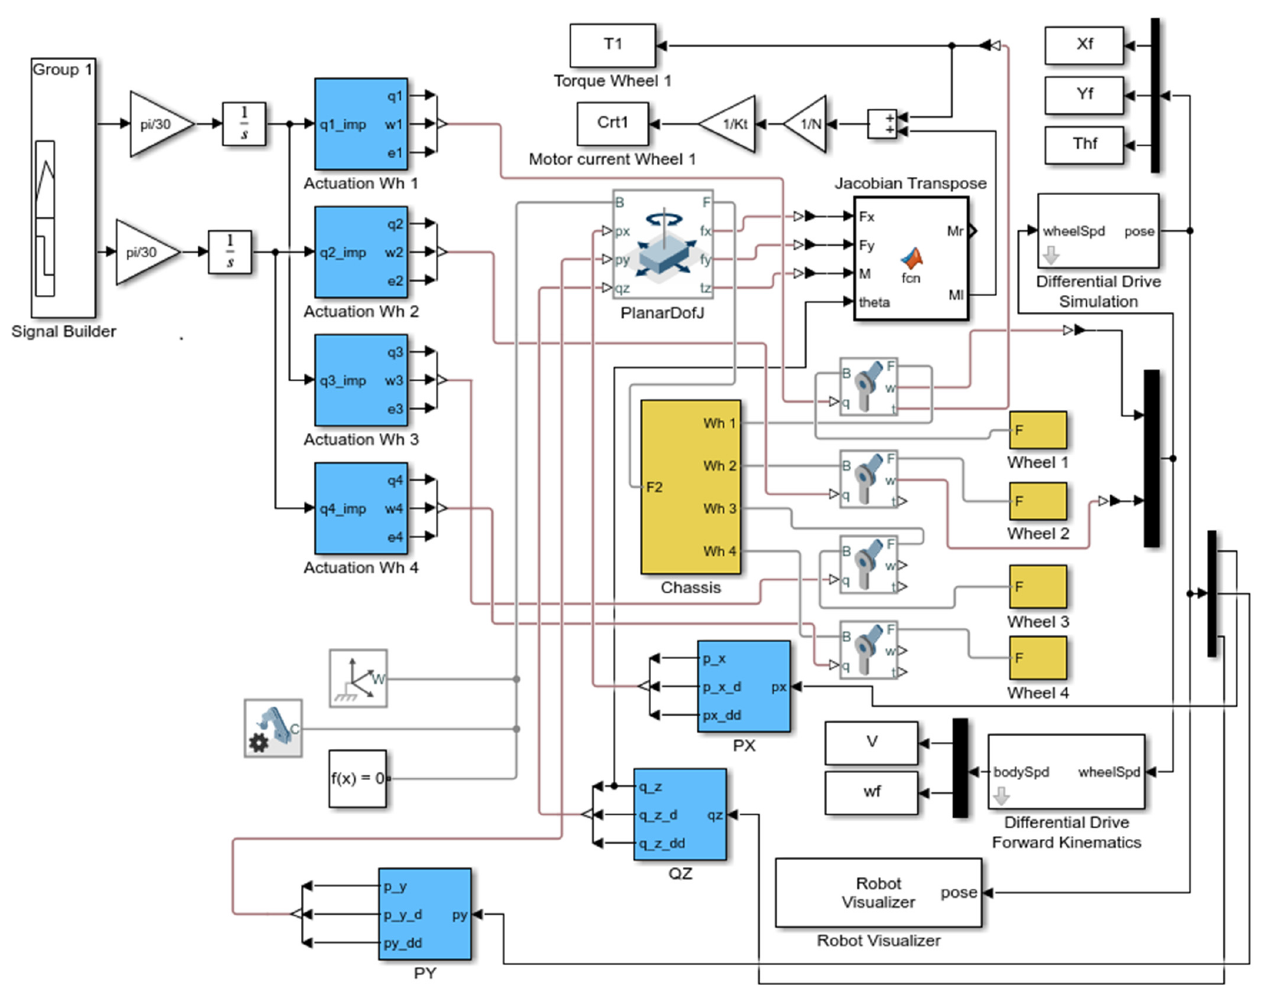
Figure 6. Simulation diagram for the differential drive kinematic solution.